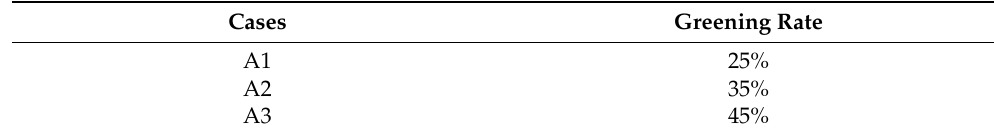
Table 4. Cases for vegetation greening.